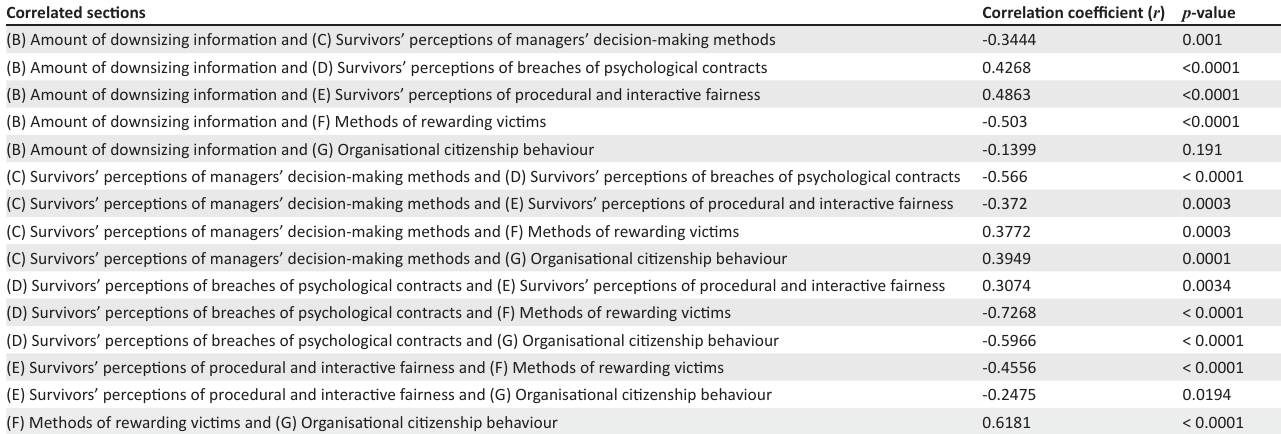
TABLE 6: Paired correlations of derived variables. Correlated sections Correlation coefficient ( r ) p